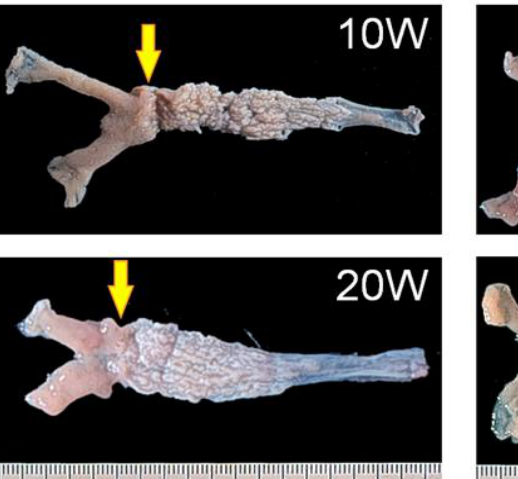
Figure 4. Coarse and tubercular lesion develops near the anastomosis at the 10th week after surgery and extends to the proximal esophagus in the rat duodenoesophageal reflux model. A large protruding lesion appears near the anastomosis at the 40th week after